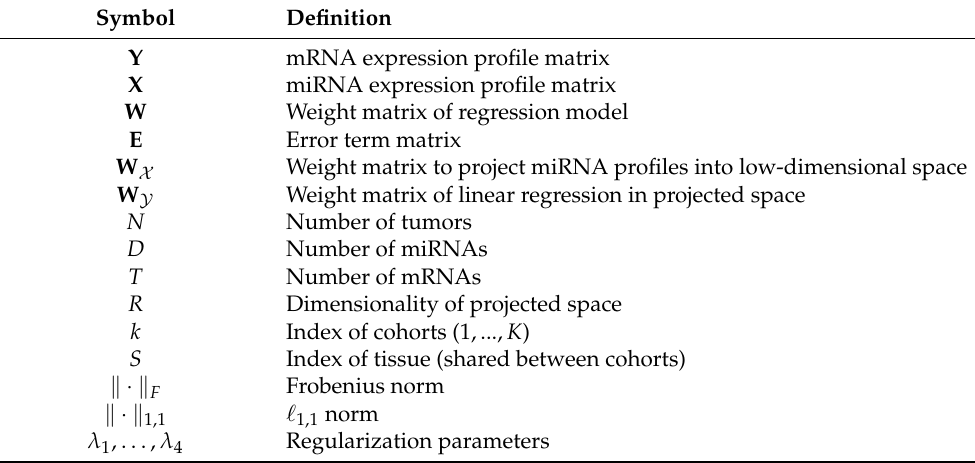
Table 1. Description of symbols used in the proposed MSRFR